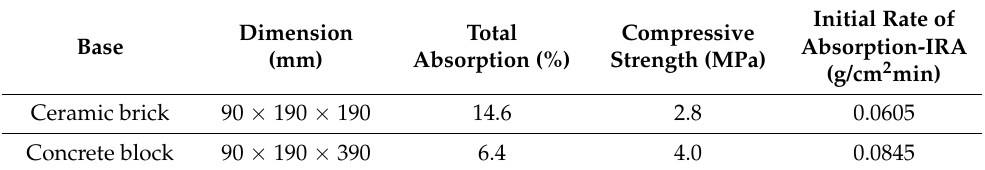
Table 4. Characteristics of the substrate used.